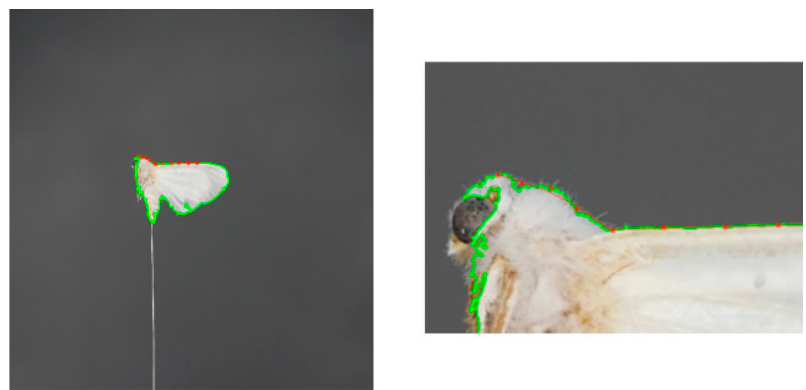
Figure 9. Edge fitting when the wings angle is greater than 180°.